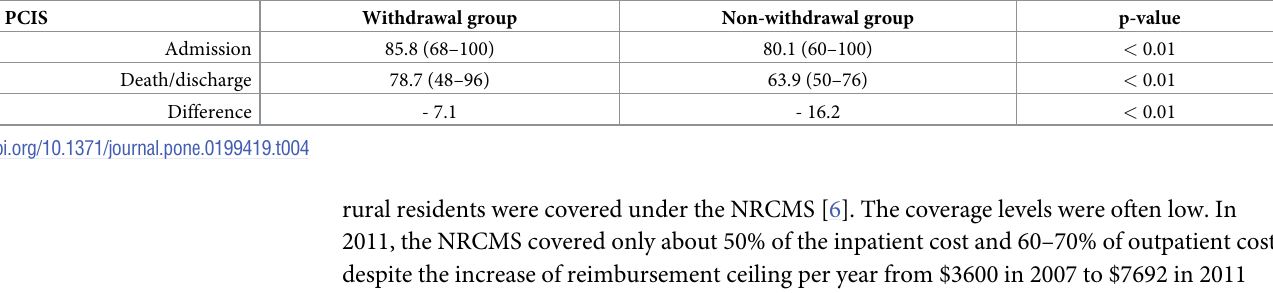
Table 4. Mean PCIS on admission and on the day of death. Average